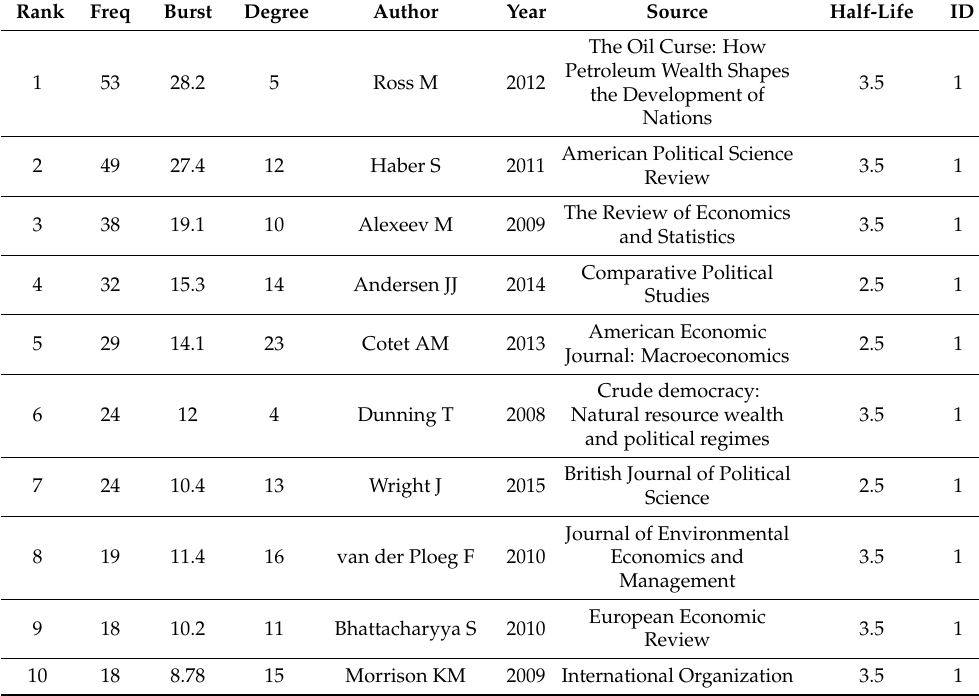
Table A3. Cluster 1 high-impact members.